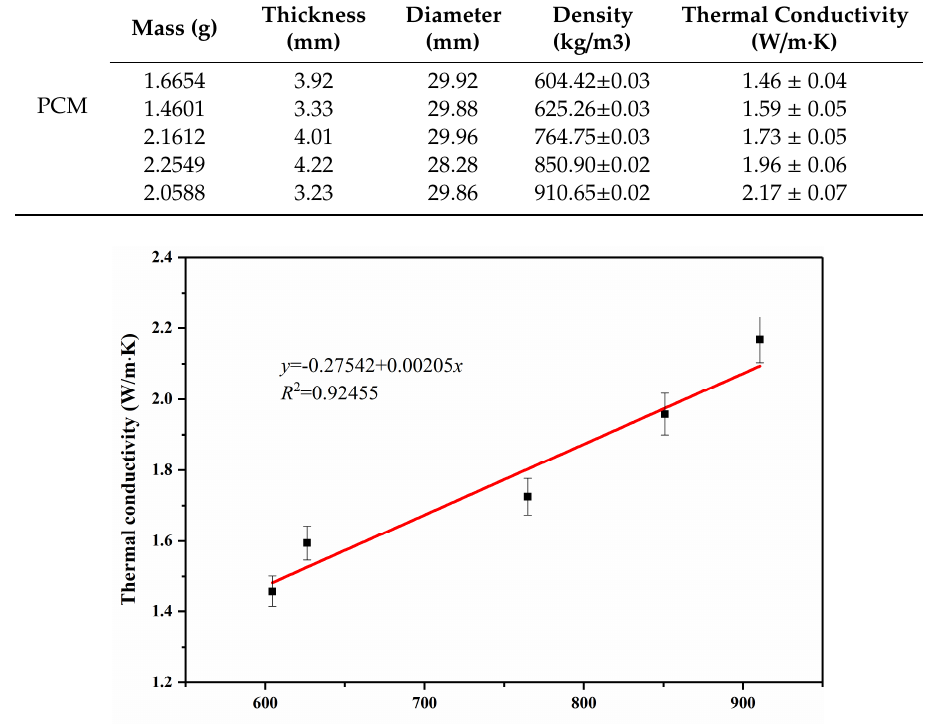
Figure 5. CA–MA / EG thermal conductivity variations with the packing Figure 5. CA–MA/EG thermal conductivity variations with the packing density.